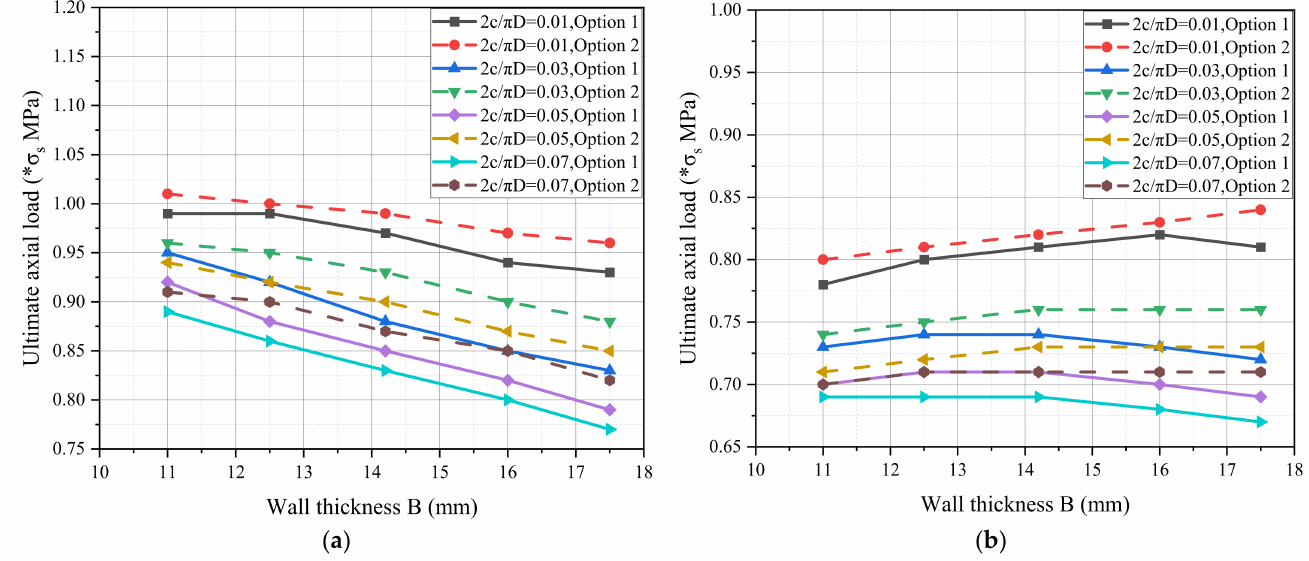
Figure 12. Ultimate axial load of girth weld cracks in pipes with different wall thickness values ( a/B = 0.3). ( a ) e = 0 mm; ( b ) e = 1 mm.